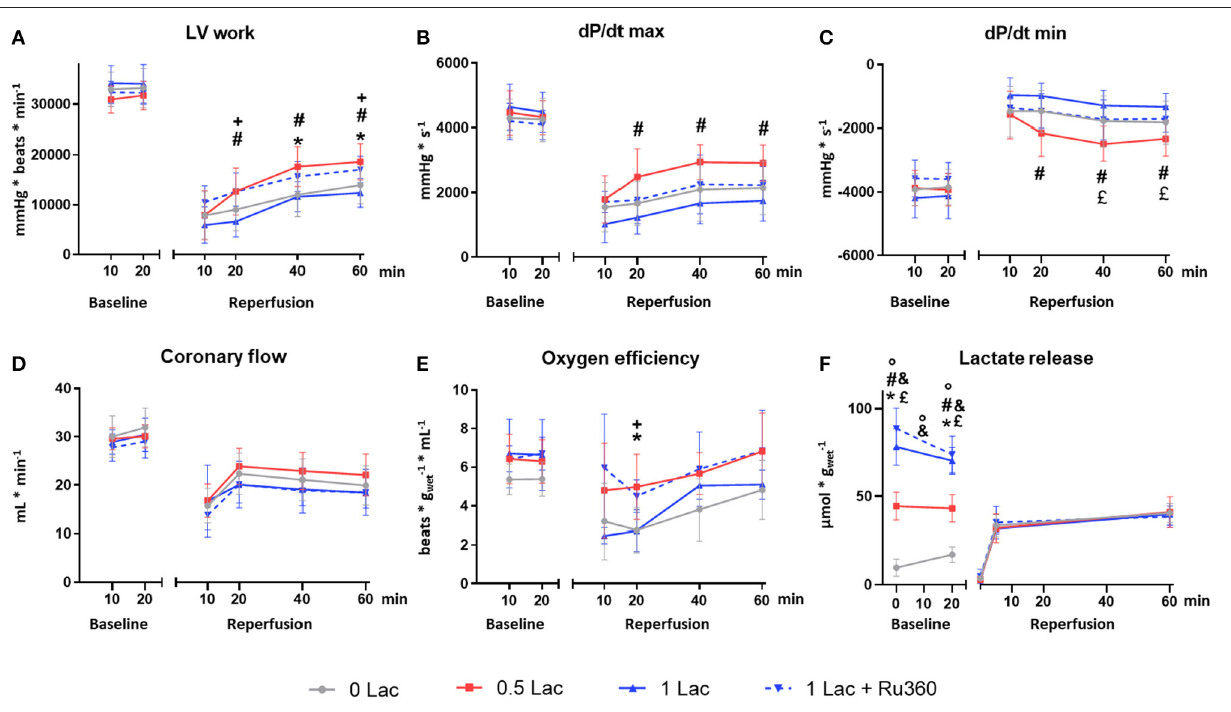
FIGURE 2 | Functional and metabolic parameters. (A) Left ventricular work (LV work = developed pressure*heart rate) (B) dP/dt max (maximum first derivative of LV pressure) (C) dP/dt min (minimum first derivative of LV pressure) (D) Coronary flow (E) Cardiac oxygen efficiency [LV work/oxygen consumption] (F) Lactate release. *